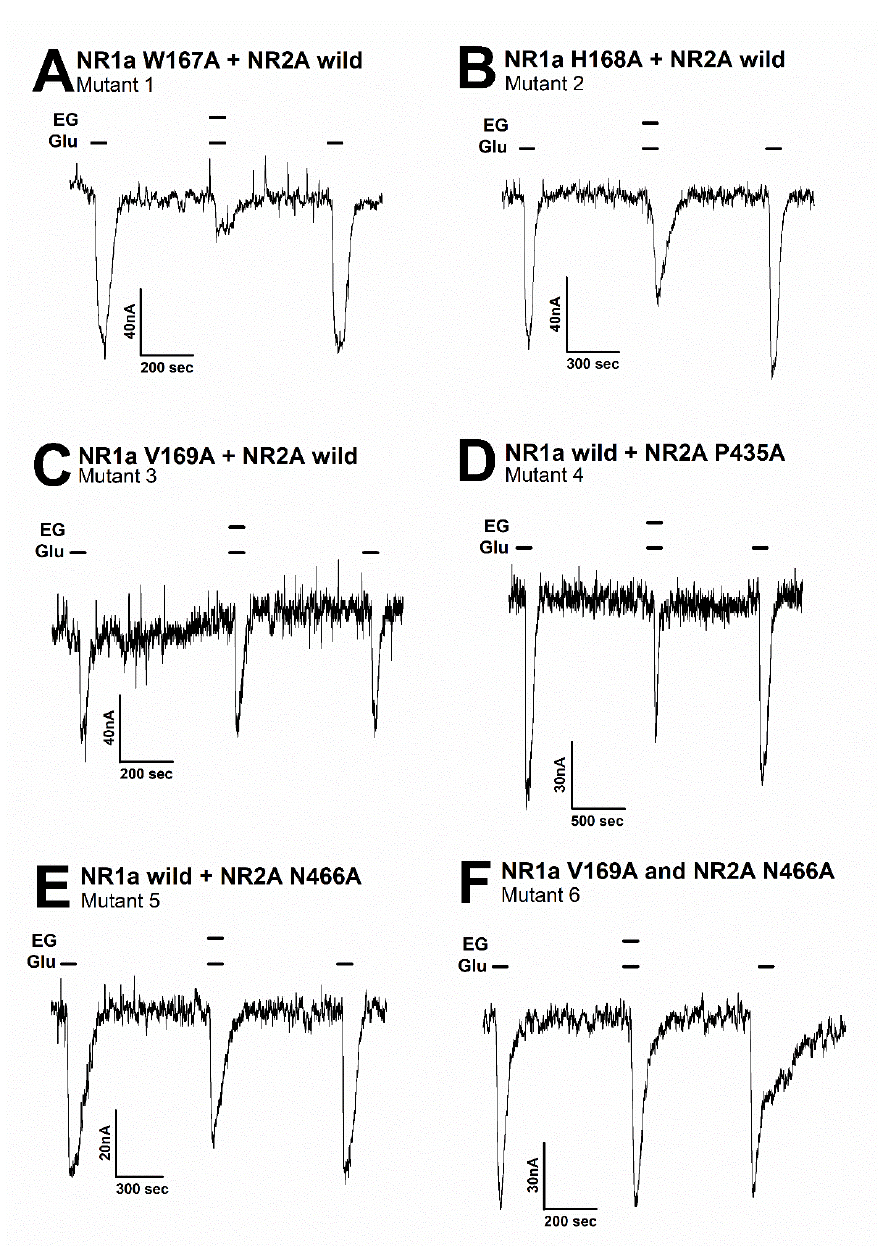
Figure 5. The inward current of several mutant types on the glutamate-evoked current of NR1a/NR2A receptor with or without ergotamine. Representative traces of current induced by application of glutamate (100 µM) alone or together with ergotamine (100 µM) for various mutants: ( A ) mutant 1 (NR1a subunit W167A and NR2A wild-type), ( B ) mutant 2 (NR1a subunit H168A and NR2A wild-type), ( C ) mutant 3 (NR1a subunit V169A and NR2A wild-type), ( D ) mutant 4 (NR1a wild-type and NR2A subunit P435A), ( E ) mutant 5 (NR1a wild-type and NR2A subunit N466A), and ( F ) mutant 6 (double mutant-type NR1a subunit V169A and NR2A subunit N466A). Experiments were performed separately, and data were collected from several oocytes ( n = 6–8 oocytes from four different frogs).